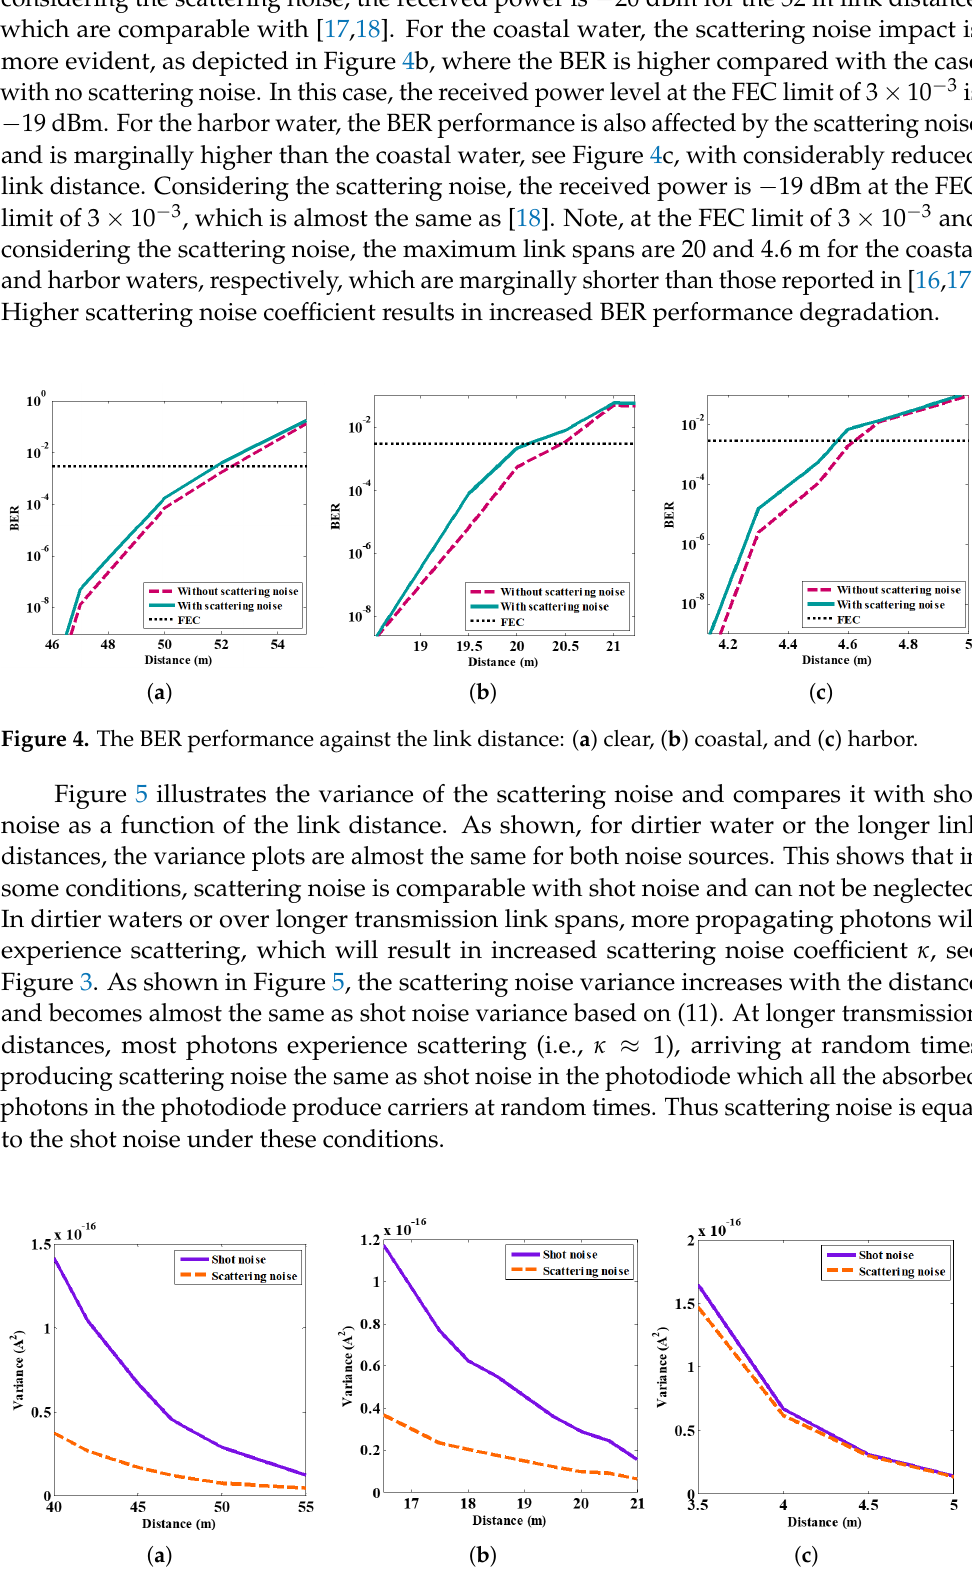
Figure 5. The variance (shot noise and scattering noise) against the link distance for three types of water: ( a ) clear, ( b ) coastal and ( c )